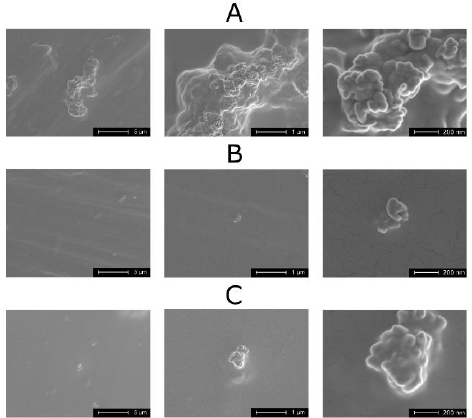
Figure 2. Chitosan coatings with nanosilver on the TiO 2 layer on the Ti13Zr13Nb alloy, Specimens A, B, and C. Magnifications 1,000 × (on the left)), 5,000 × (at the center) and 25,000 × (on the right).